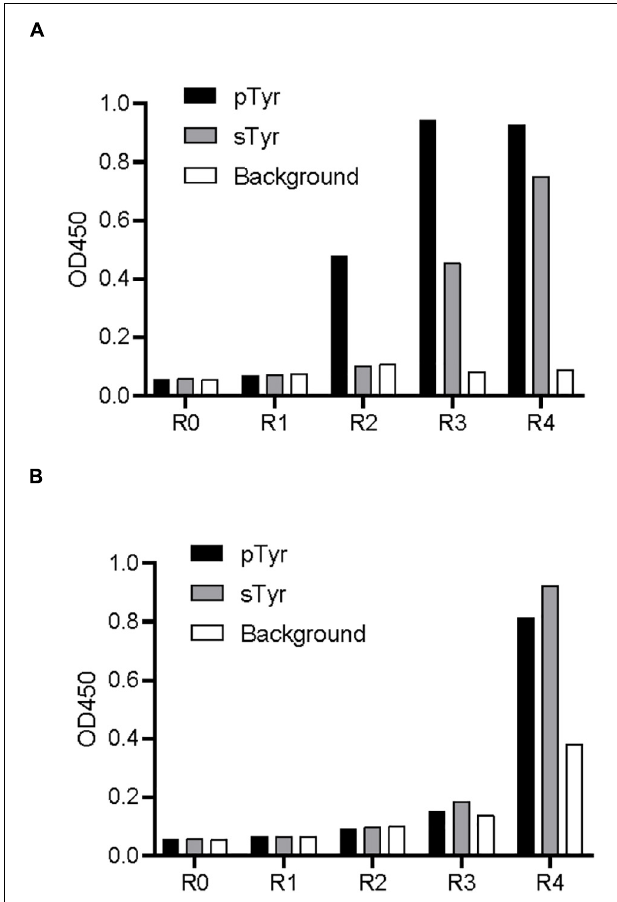
FIGURE 2 | Biopanning of the SH2 variant library against pTyr and sTyr peptides. (A) Phage ELISA of the selected phages from each biopanning round against pTyr and the naïve library binding to pTyr peptide and sTyr counterpart. R0 refers to the naïve library. R1–R4 stands for phage panning cycle Rounds 1–4. (B) Phage ELISA of the selected phages from each biopanning round against sTyr and the naïve library binding to pTyr peptide and sTyr counterpart. Streptavidin precoated in the microplate was taken as the background.